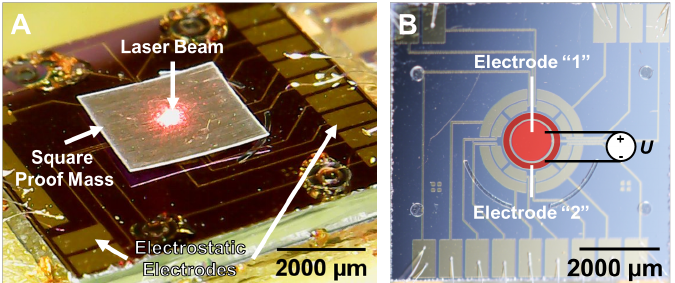
Figure 1. ( A ) HLMA levitating square-shaped proof mass with a 2.8mm side length and at a height of 70µm. ( B ) The set of electrodes fabricated on the surface of the device layer of SOI wafer: the energized electrodes by the applied voltage U to carry out the pull-in actuation of the levitated PM are highlighted in